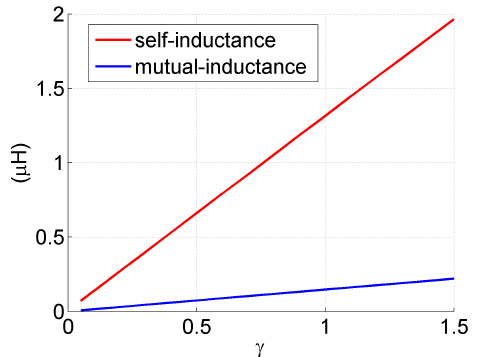
Figure A2. Mutual inductance and transmitter self-inductance versus the scaling factor.